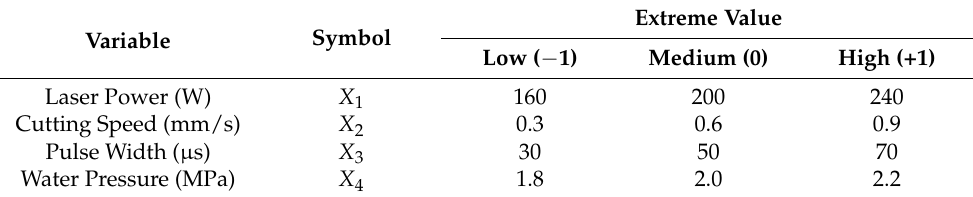
Table 5. Independent variable and experimental design level used in the BBD.